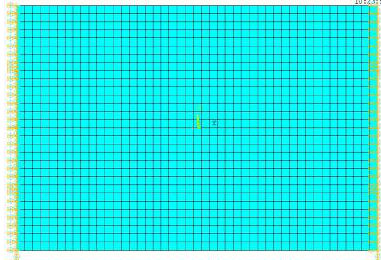
Fig. 4 Finite element modeling of the glass panel.